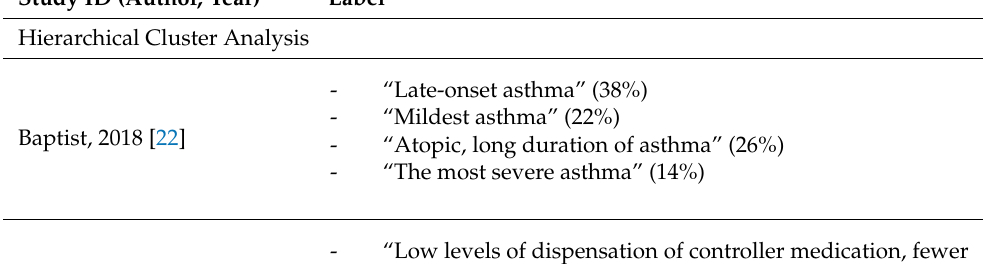
Table A2. Asthma phenotypes in adult patients were derived by data-driven methods in the included studies and stratified by the data-driven method applied. The percentage of subjects that belong to each phenotype is presented when